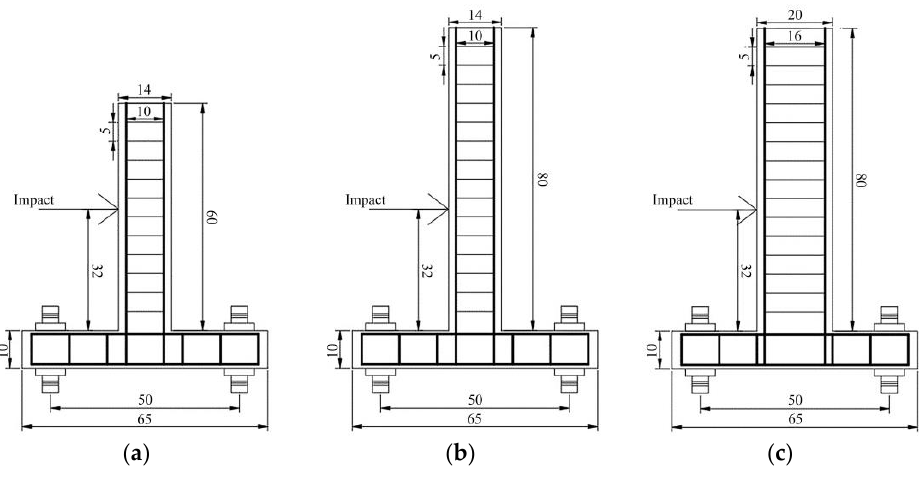
Figure 5. Dimensions of RCC specimens (unit: cm): ( a ) C_1; ( b ) C_2; ( c ) C_3. During the experiment, the following measurements were collected: (1) the concrete vertical and transverse strains on the backside of the impact location; (2) the rebar vertical strain on the backside of the impact location; and (3) the concrete and rebar vertical strains at the bottom. The validity of the strain gauge at the measuring point was checked before the experiment.